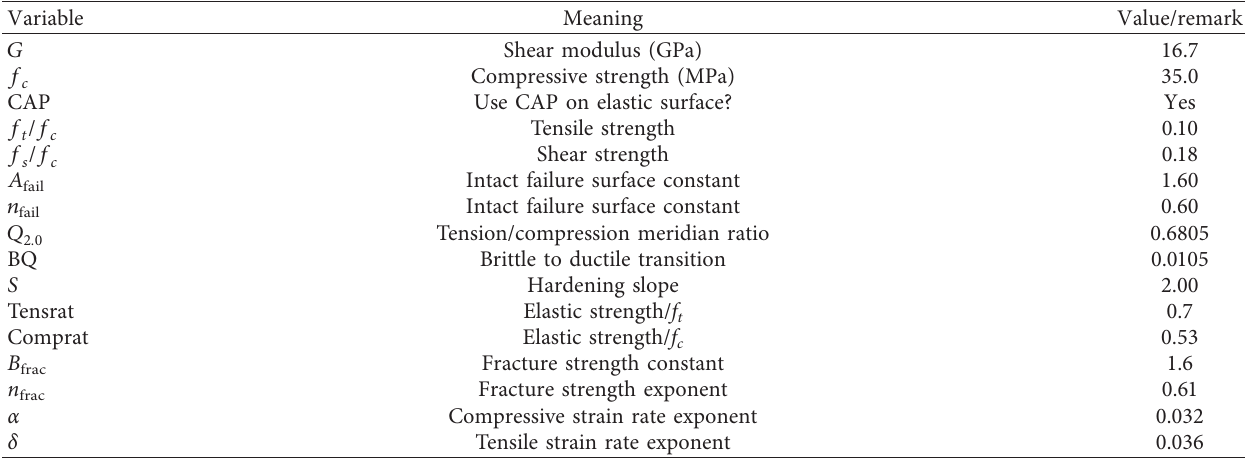
Table 3: RHT concrete strength model parameters for C-35 concrete.